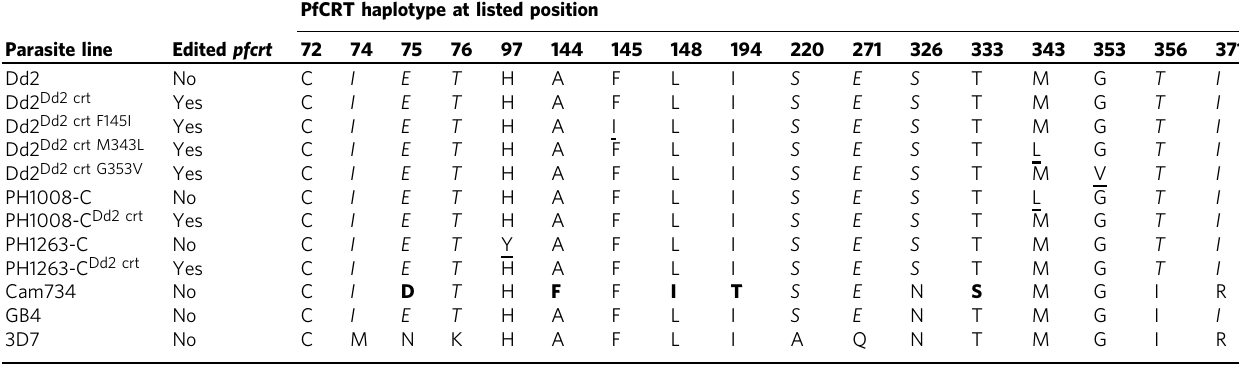
Table 1 Haplotypes of pfcrt -edited and control P. falciparum lines PfCRT haplotype at listed